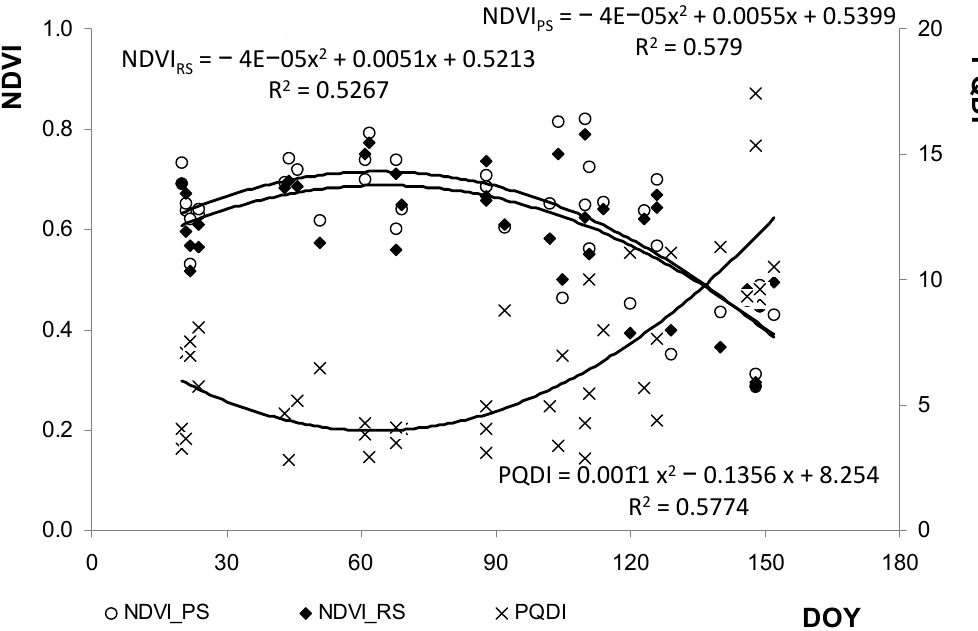
Figure 18. General pattern of mean NDVI (obtained by proximal and remote sensing) and PQDI in function of DOY, for the set of experimental fields and pasture sampling dates (2019 and 2020).